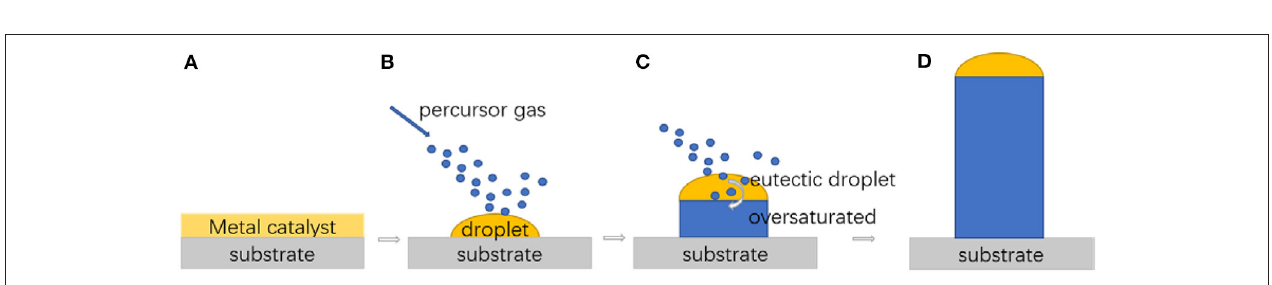
FIGURE 9 | Fishbone NW. (A) SEM image of the suspended fishbone nanostructure; (B) Enlarged top view; (C) Schematic of micro time domain thermoreflectance setup, with recorded signal and exponential fit. Reprint with permission from Maire et al. (2018).